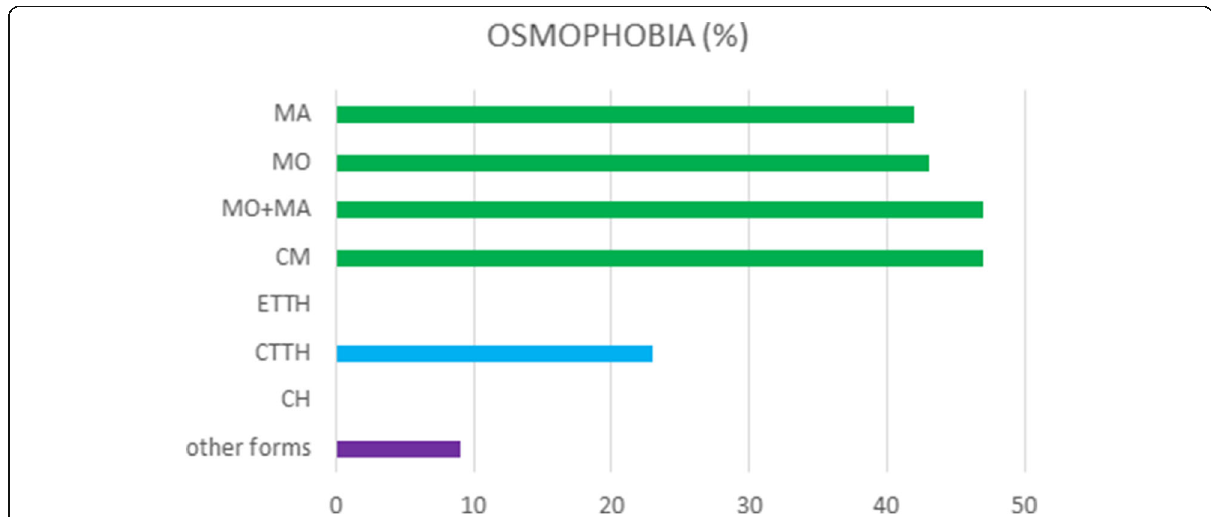
Fig. 2 Prevalence of osmophobia among different diagnosis. MO Migraine WithOut Aura. MA Migraine With Aura. CM: Chronic Migraine. ETTH: Episodic Tension Type Headache. CTTH: Chronic Tension Type Headache. CH: Cluster